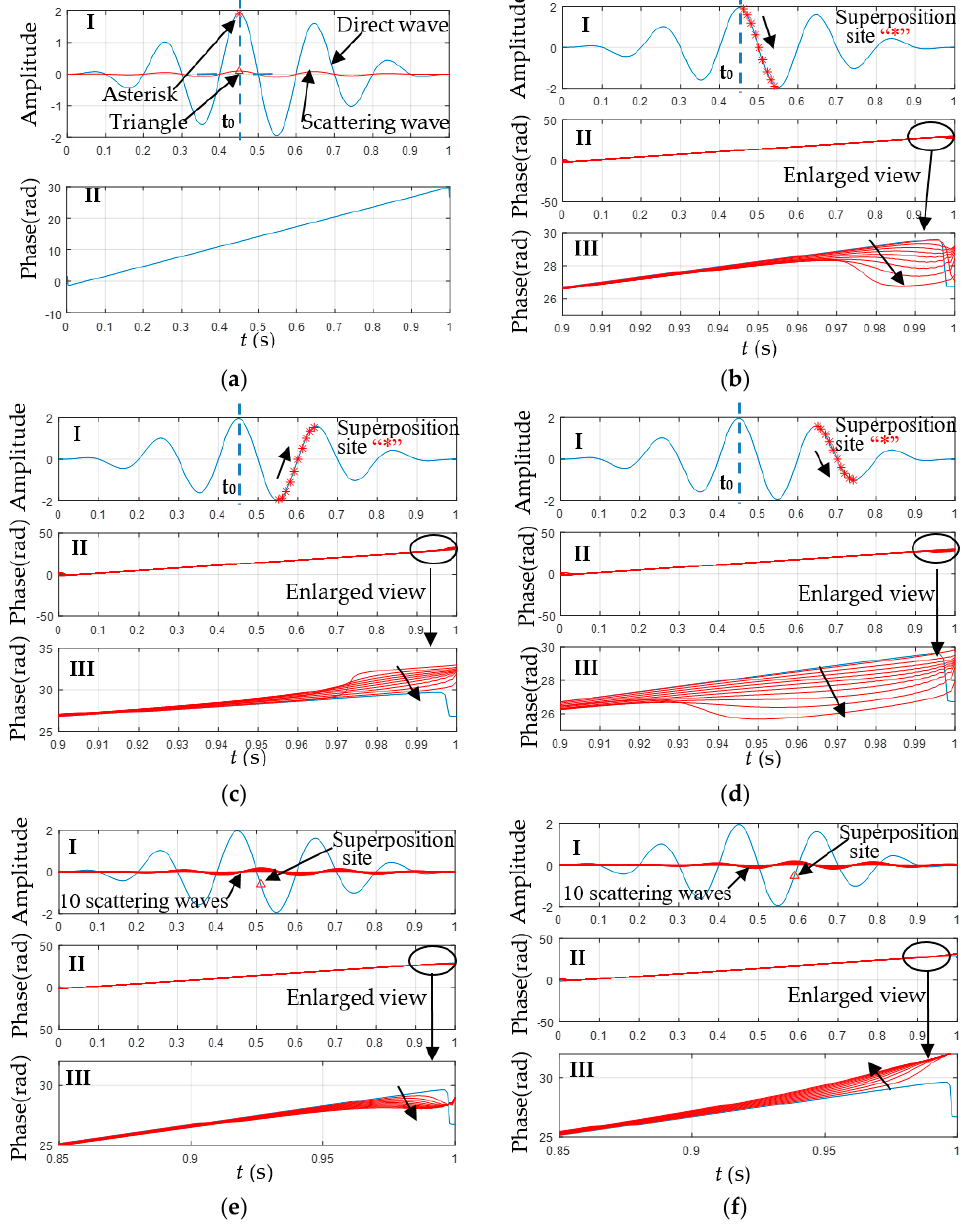
Figure 3. The experiment of the instantaneous phase change of the monitoring signal model. ( a ) Subfigure ( I ) shows the direct wave and the scattering wave, and subfigure ( II ) shows the